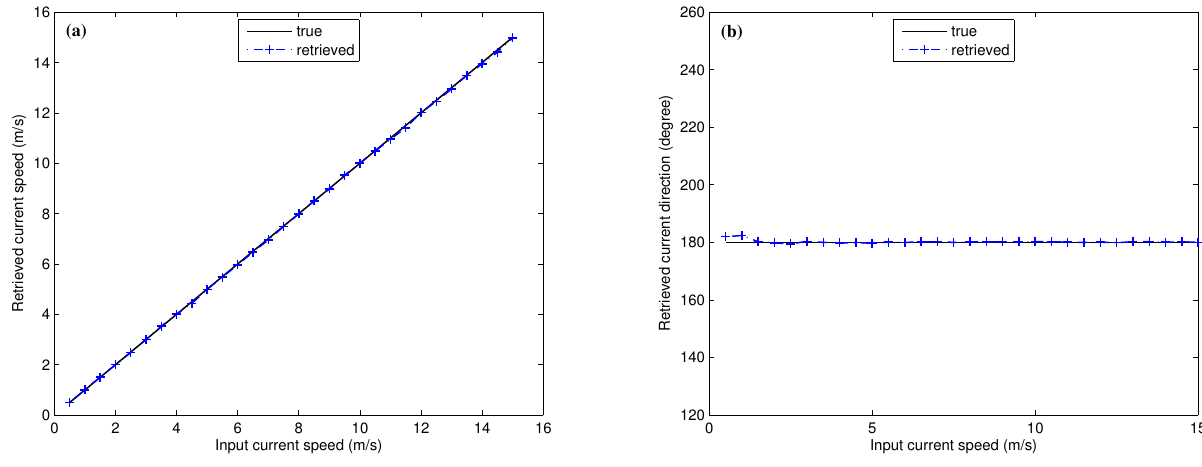
Figure 4. Comparison of input and retrieved current: ( a ) speed; ( b )